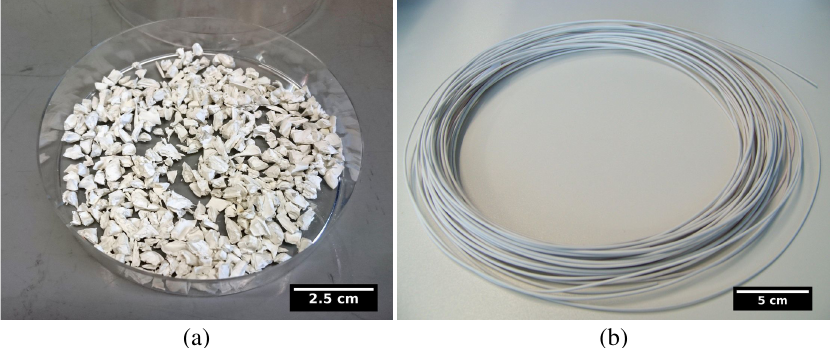
Figure 2. ( a ) A photo of the ABS-BT feedstock after kneading. ( b ) An ABS-BT composite filament sample. Filament